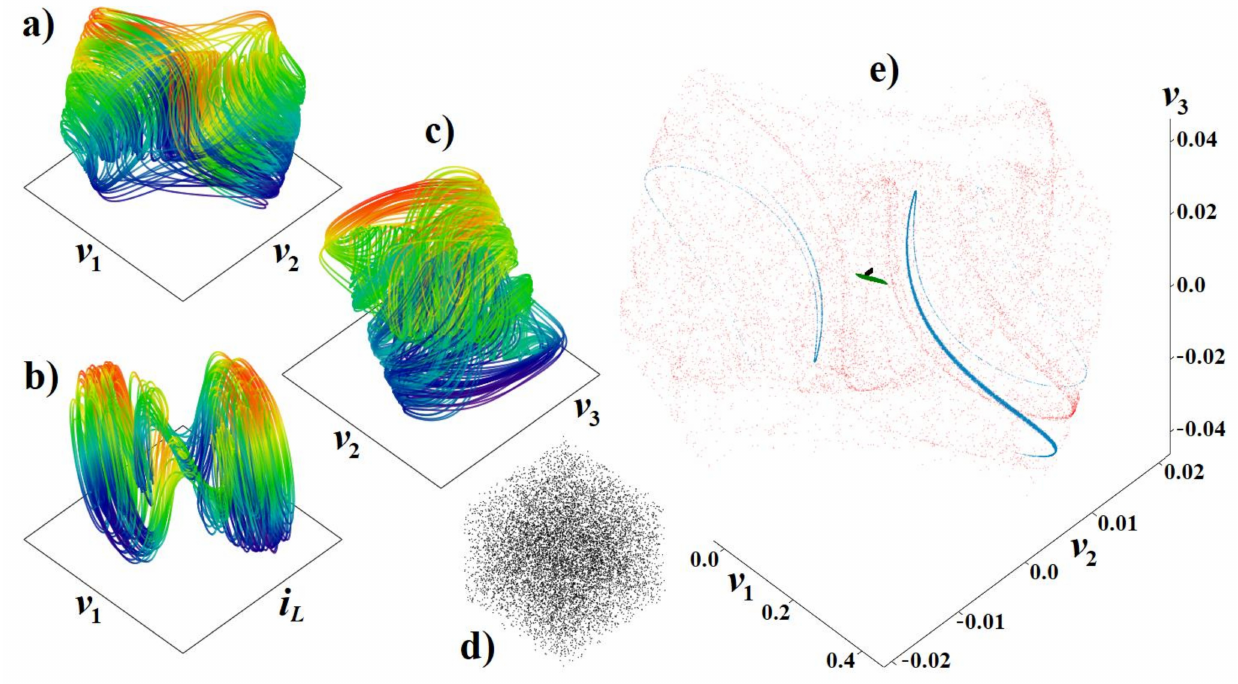
Figure 8. Analysis of isolated resonant amplifier with Darlington-type cell, fourth order dynamical system: ( a ) subspace v 1 - v 2 - v 3 , ( b ) subspace v 1 - v 2 - i L , ( c ) subspace v 2 - v 3 - i L , ( d ) hypercube of randomly generated sets of the initial conditions, ( e ) short-time system evolution. See text for clarification of individual